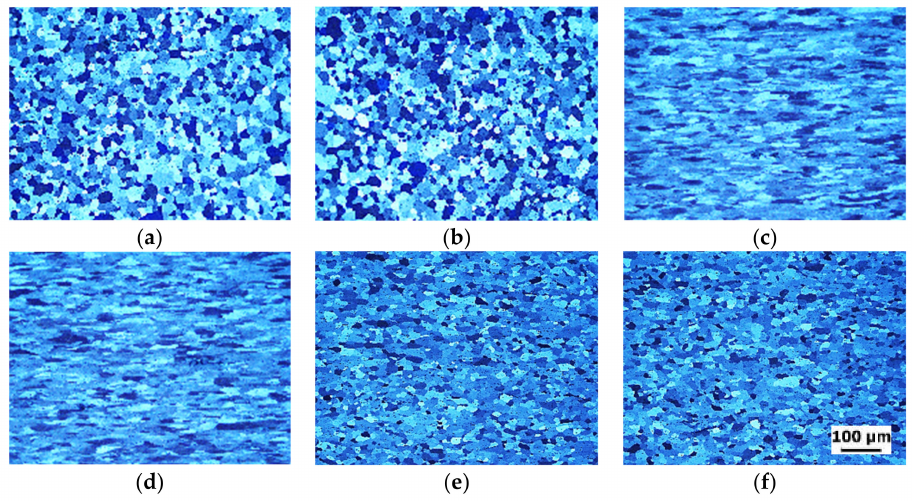
Figure 4. Optical micrographs of ( a ) E, ( b ) ES, ( c ) CR, ( d ) CRS, ( e ) A, and ( f ) AS (electro etching).